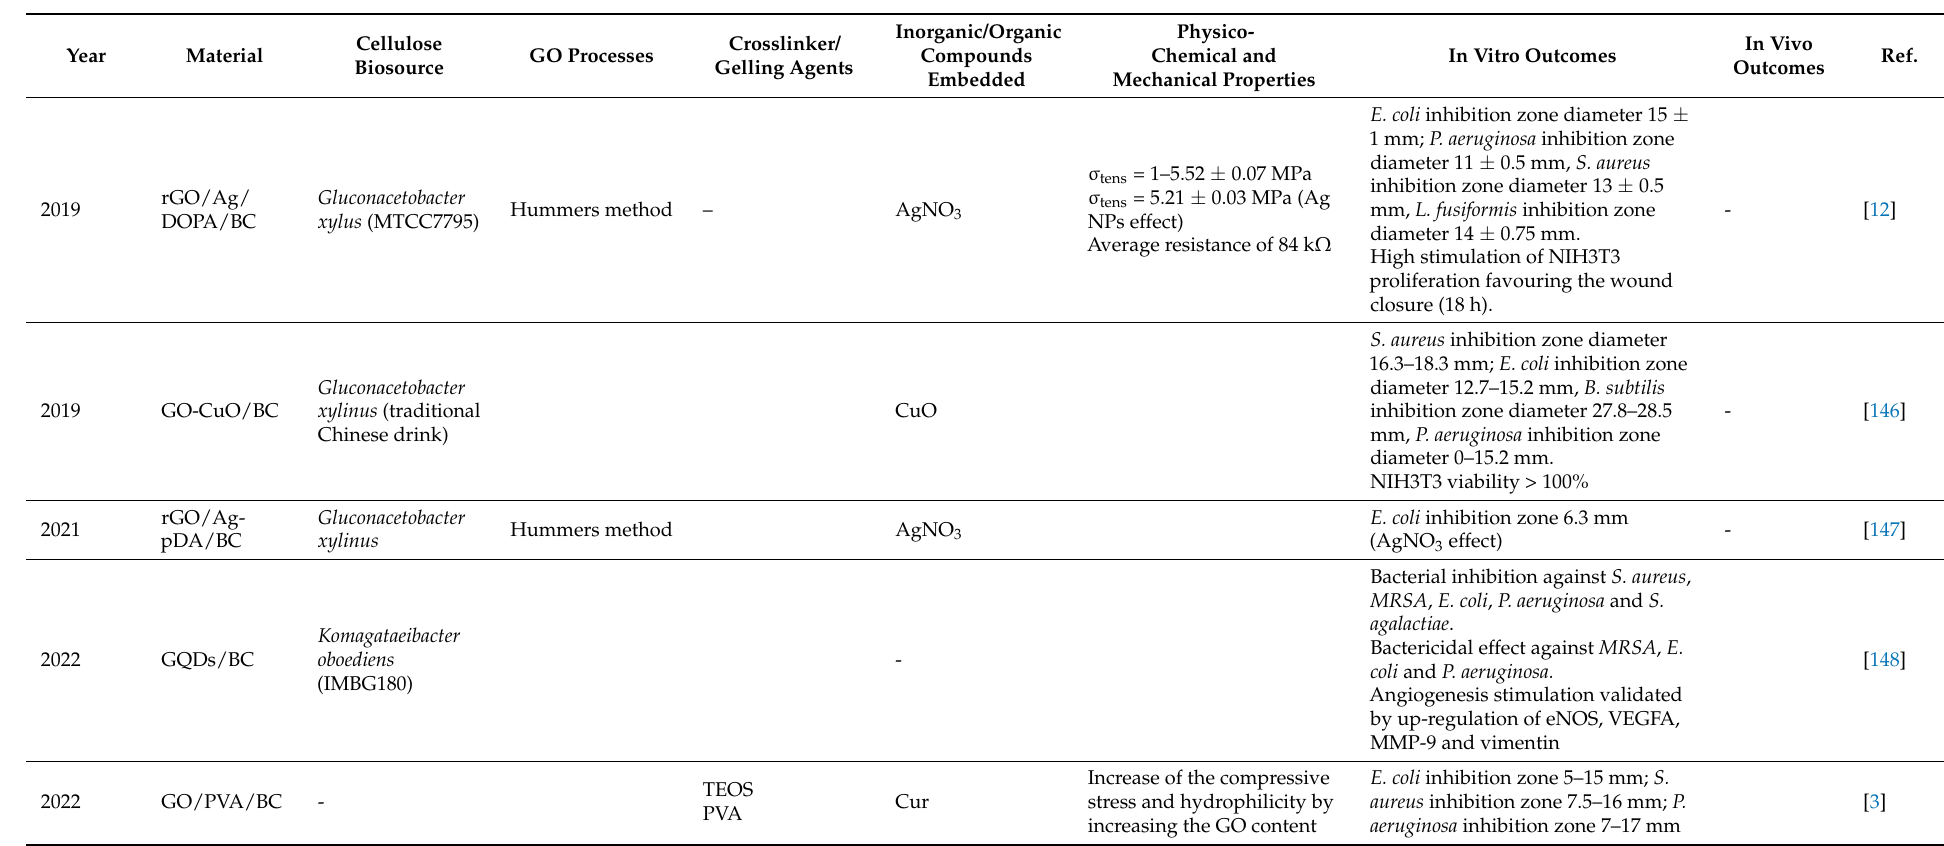
Table 5. List of the papers focused on bacterial cellulose based composites functionalised with GO(rGO) for wound healing